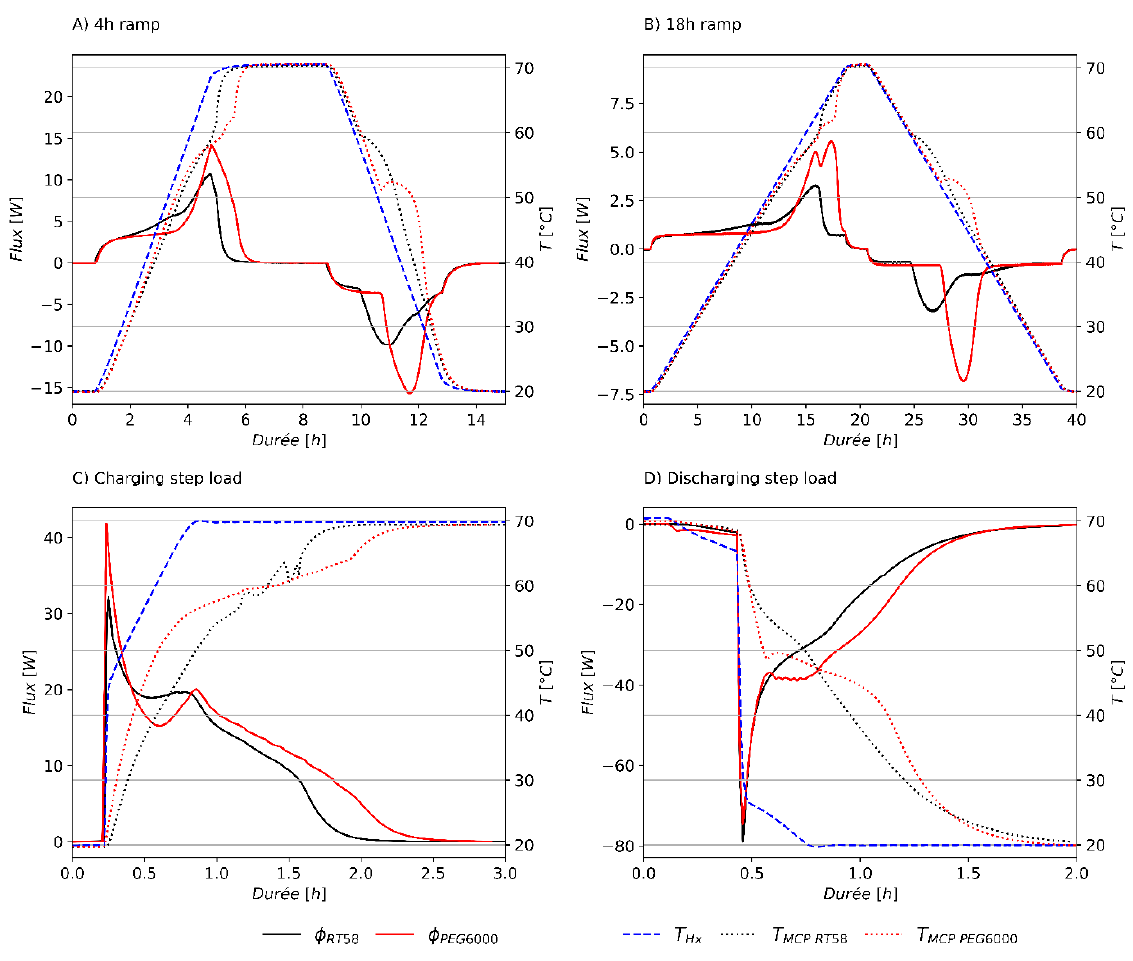
Figure 8. Heat flux and temperature measurements of RT58 and PEG6000 for a 4 h ramp ( A ), 18 h ramp ( B ), charging step load ( C ), and discharging step load ( D ).